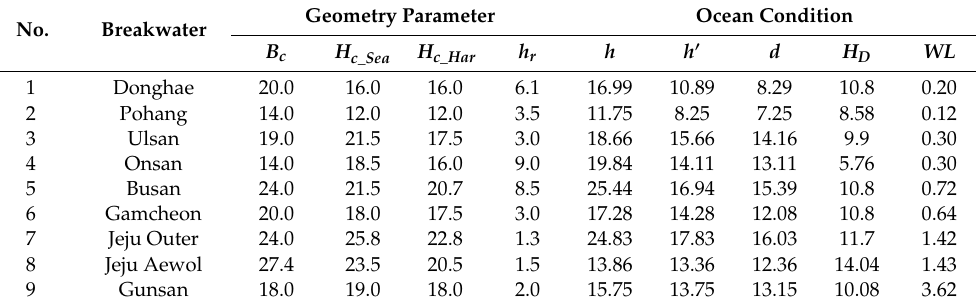
Figure 3. Typical cross-section of a BRW and wave force model. Table 1. Dimensions and Environmental Characteristics of the